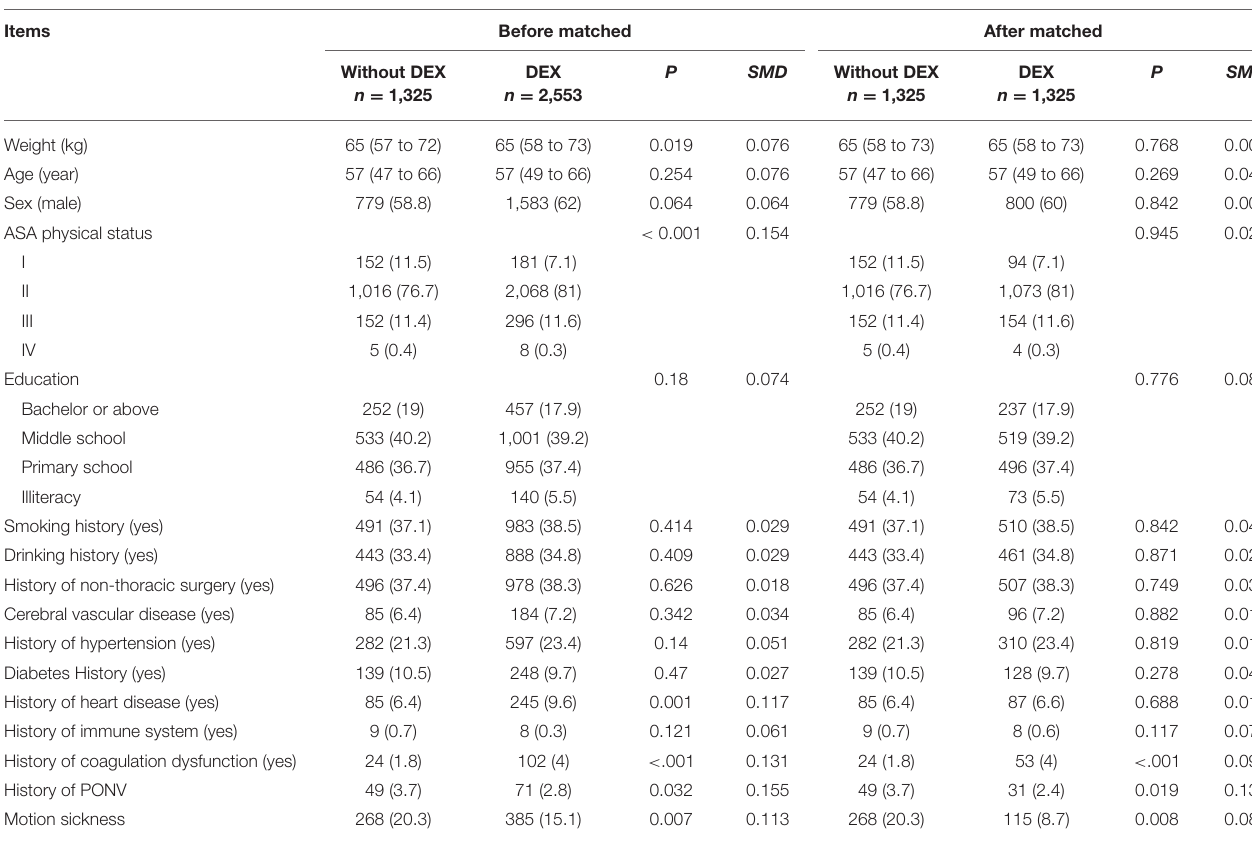
TABLE 1 | Patients